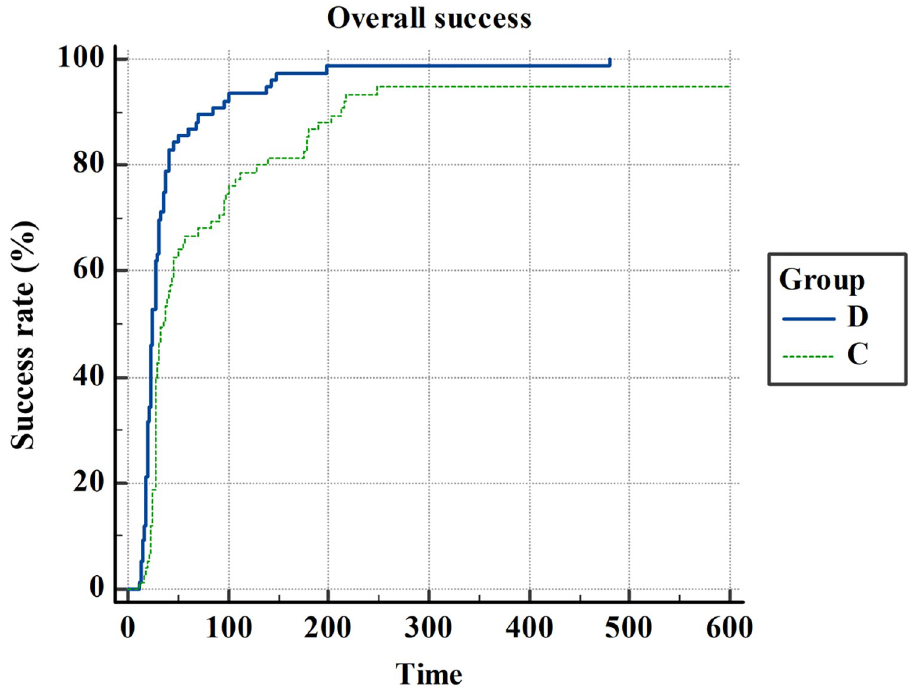
Fig 3. Kaplan–Meier curves for the overall catheterization success time. D: Group D, dynamic needle tip positioning method. C : Group C, conventional short-axis method. Time(x-axis) is defined as the time from the start of ultrasound scanning during the first attempt to the appearance of an arterial waveform on the monitor. If cannulation was not successful with the assigned method after 10 min, it was defined as cannulation